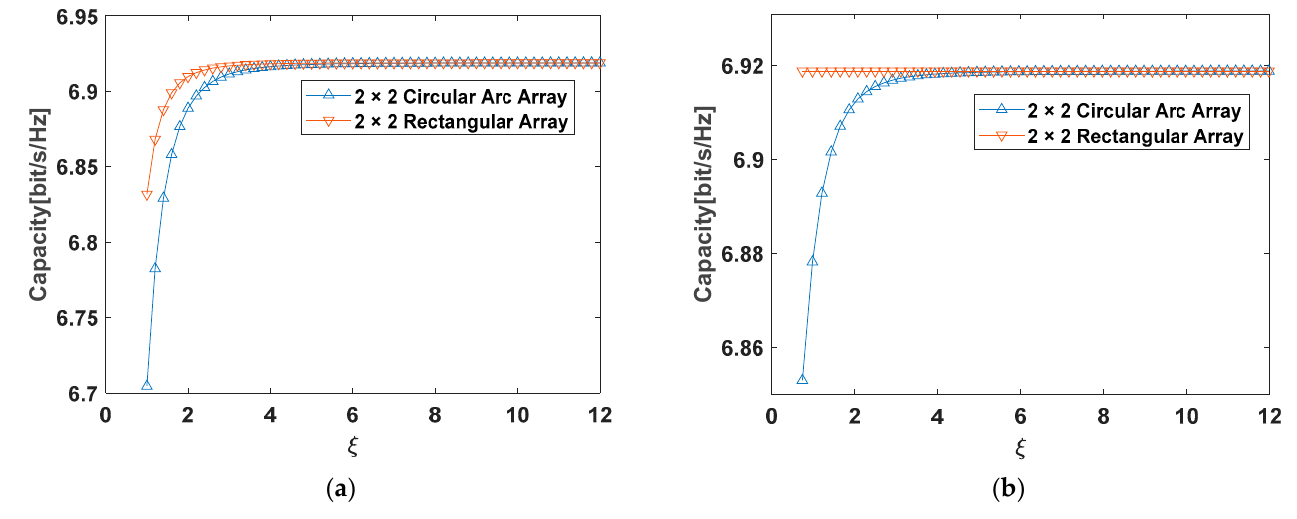
(cid:2869) . . (cid:2876)(cid:3041) 8 n